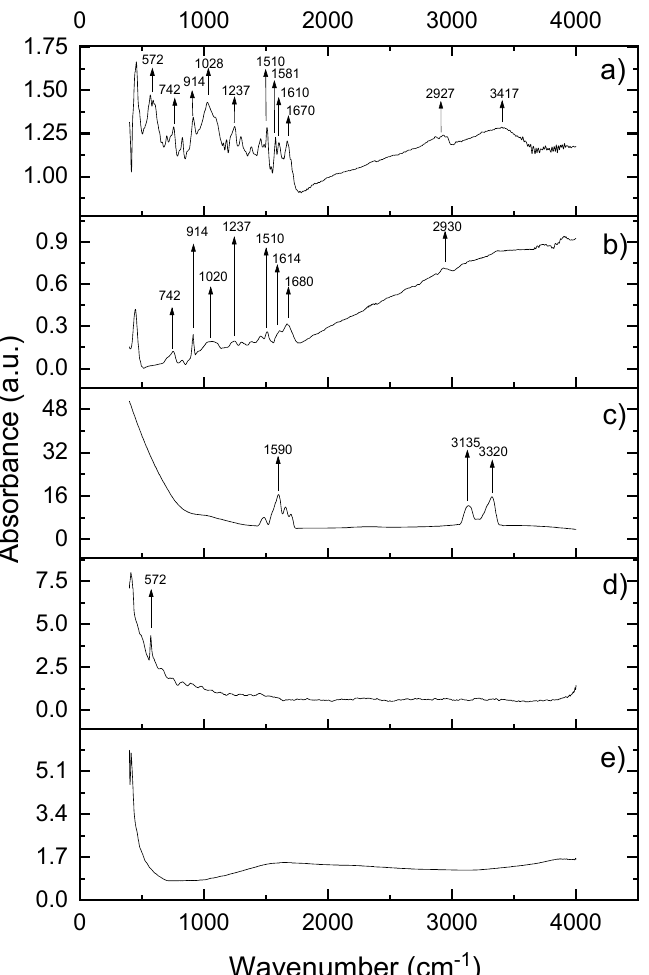
Figure 1. FTIR spectra of modified root canal sealer obtained by incorporation of ( a ) AgNPs/CHX/CNTs mixture; ( b ) commercial root canal sealer (ADSeal); ( c ) chlorhexidine gluconate gel; ( d ) colloidal AgNPs and ( e ) neat CNTs (as received from the manufacturer).